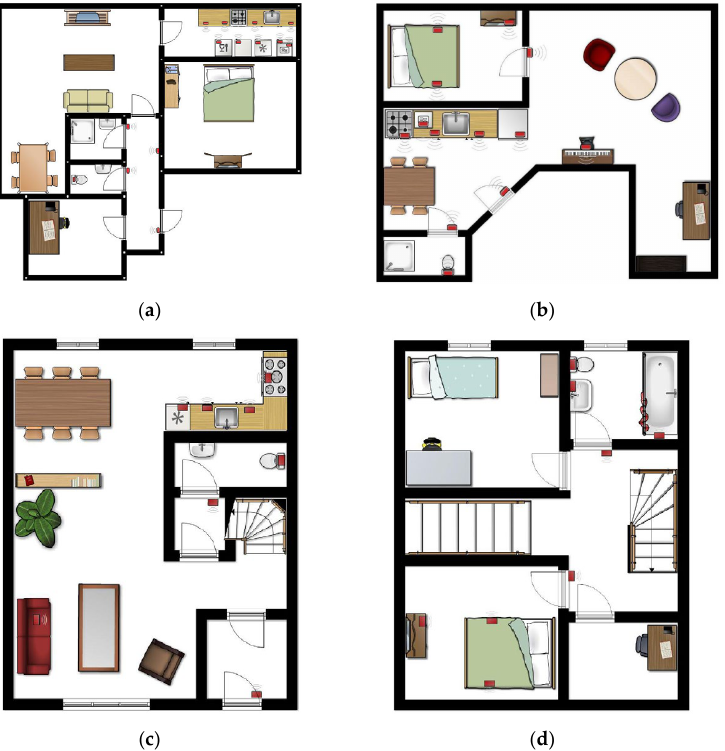
Figure 8. Floor plans of Kasteren houses; red boxes represent the sensors [47]. ( a ) House A. ( b ) House B. ( c ) House C, first floor. ( d ) House C, second floor.